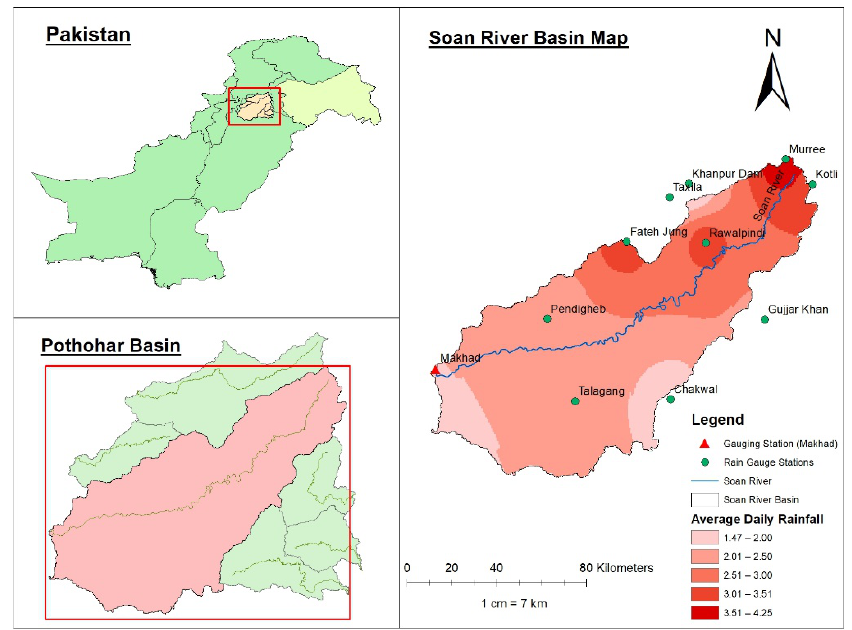
Figure 1. Map of the Soan River basin and location of rain gauges and gauging station.